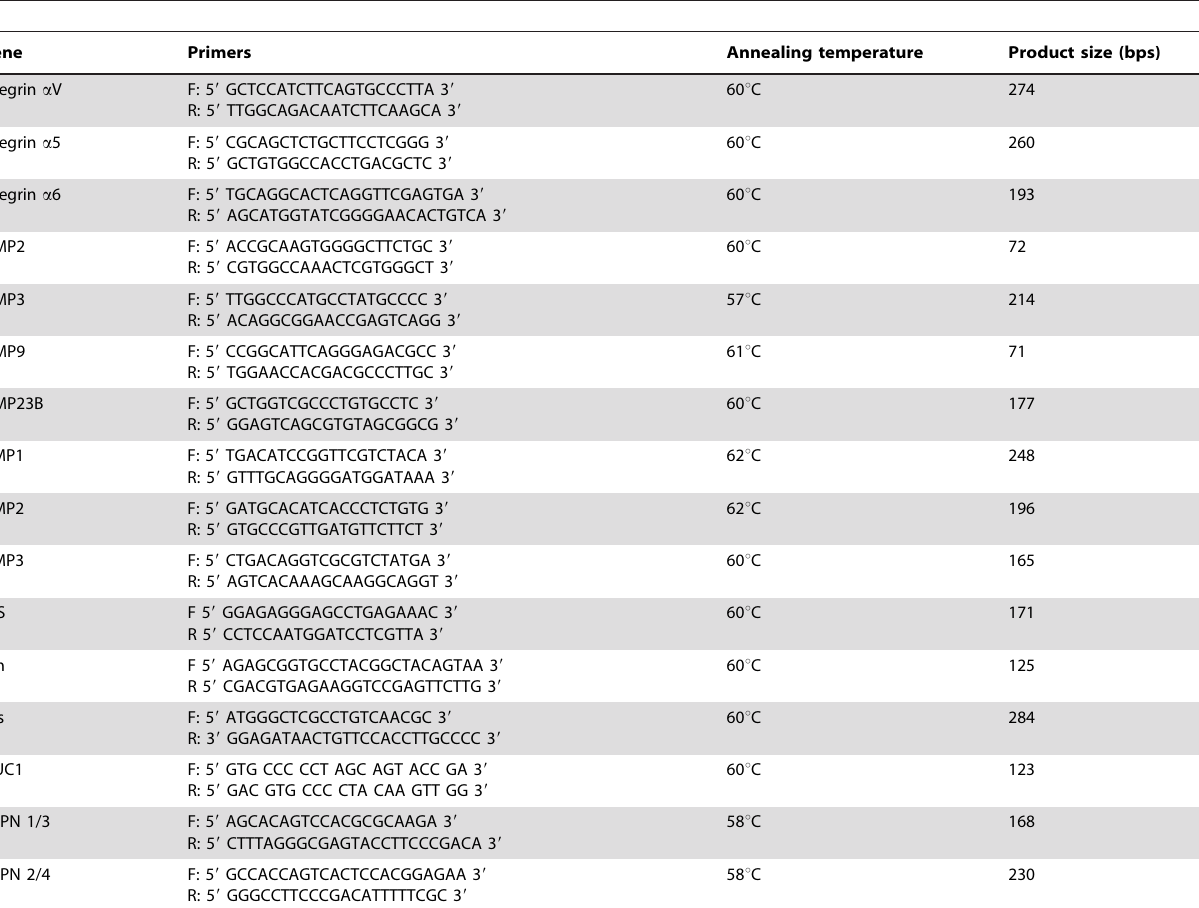
Table 1. Primer sequences used for the real-time